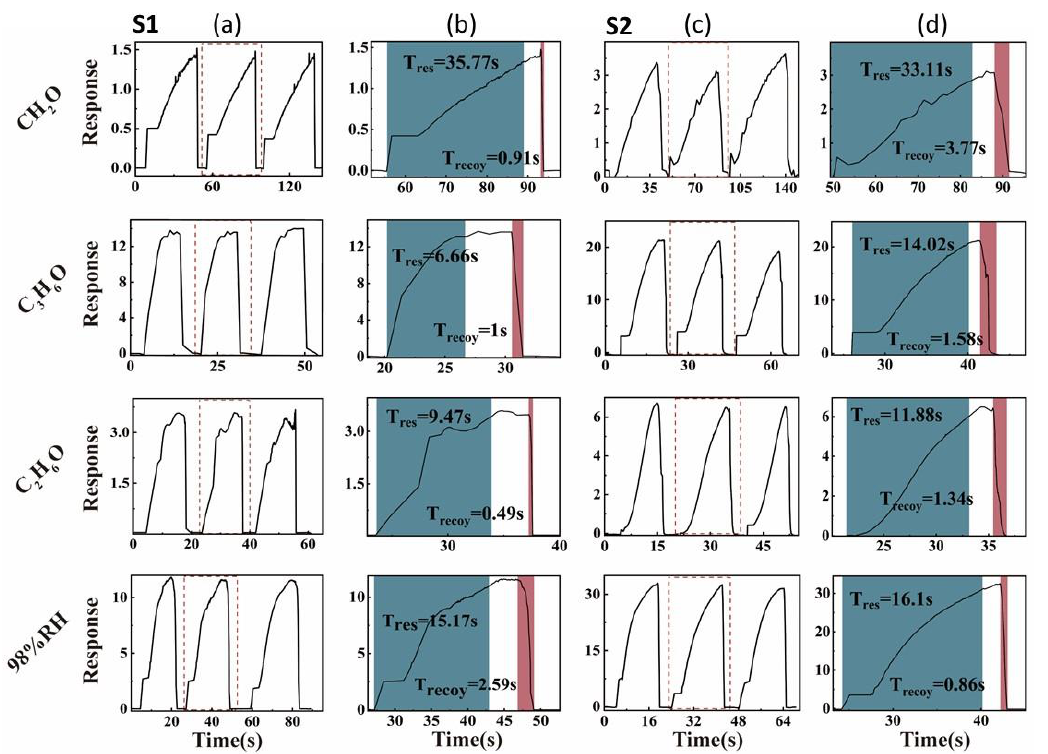
Figure 4. Sensing curves in the presence of different target gases of S1 and S2. ( a , c ) Gas-sensitive properties of S1 and S2 at 98% RH and 1000 ppm of CH 2 O, C 3 H 6 O, and C 2 H 6 O, respectively. ( b , d ) Response time of S1 and S2 at 98% RH and 1000 ppm of CH 2 O, C 3 H 6 O, and C 2 H 6 O, respectively.